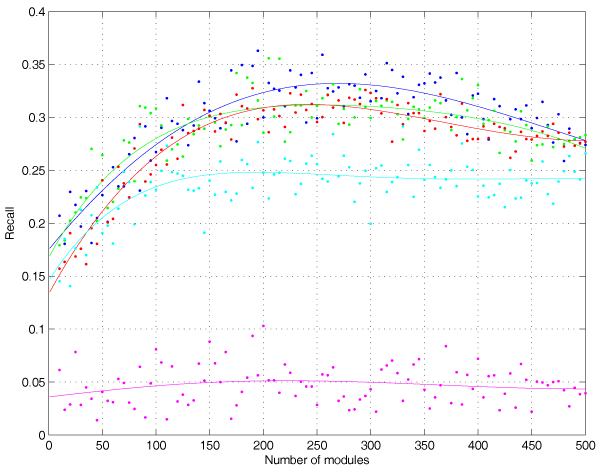
Recall as a function of the number of modules and experiments. Recall as a function of the number of modules for data sets with 10 (magenta), 50 (cyan), 100 (red), 200 (green), and 300 (blue) experiments. The curves are least squares fits of the data to a linear non-polynomial model of the form a0+∑k=1nakxk−1e−x/500
MathType@MTEF@5@5@+=feaafiart1ev1aaatCvAUfKttLearuWrP9MDH5MBPbIqV92AaeXatLxBI9gBaebbnrfifHhDYfgasaacH8akY=wiFfYdH8Gipec8Eeeu0xXdbba9frFj0=OqFfea0dXdd9vqai=hGuQ8kuc9pgc9s8qqaq=dirpe0xb9q8qiLsFr0=vr0=vr0dc8meaabaqaciaacaGaaeqabaqabeGadaaakeaacqWGHbqydaWgaaWcbaGaeGimaadabeaakiabgUcaRmaaqadabaGaemyyae2aaSbaaSqaaiabdUgaRbqabaGccqWG4baEdaahaaWcbeqaaiabdUgaRjabgkHiTiabigdaXaaakiabdwgaLnaaCaaaleqabaGaeyOeI0IaemiEaGNaei4la8IaeGynauJaeGimaaJaeGimaadaaaqaaiabdUgaRjabg2da9iabigdaXaqaaiabd6gaUbqdcqGHris5aaaa@461A@ with x the number of modules and n = 3.